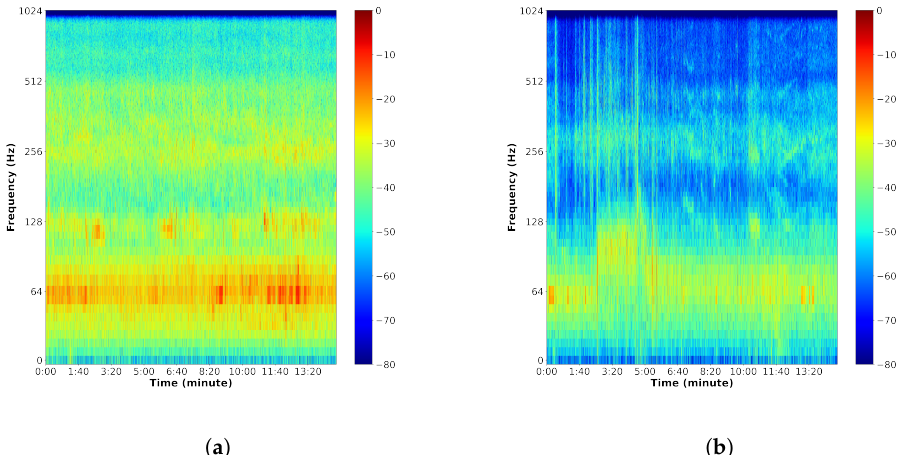
Figure 10. Spectrogram comparisons when human speech is ( a ) not present and ( b ) present near the hives.